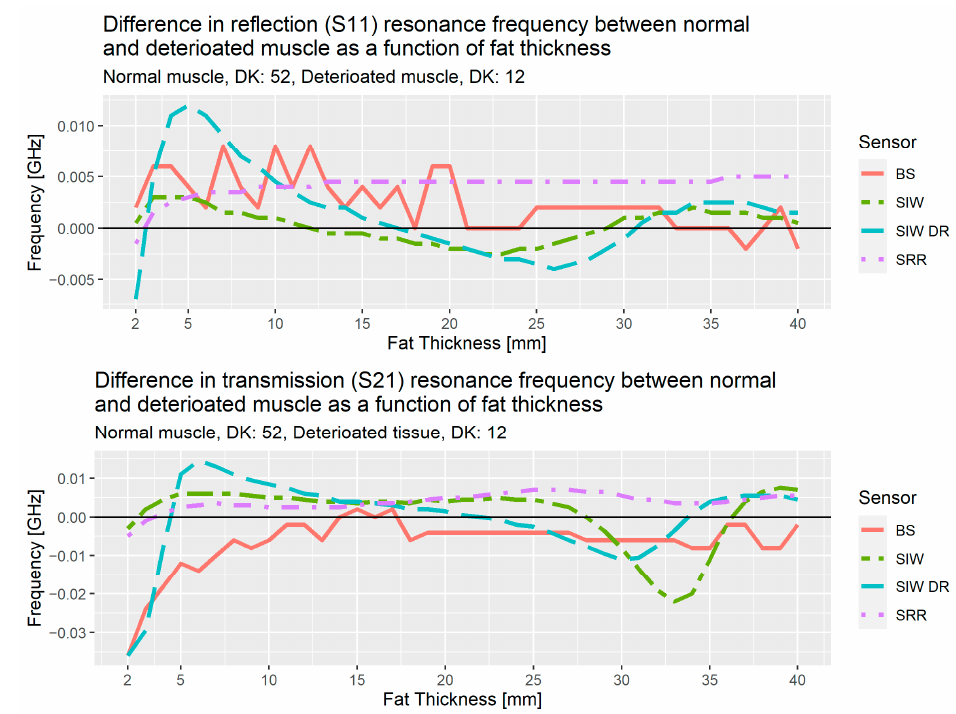
Figure 16. Difference in resonance frequency for reflection and transmission as a function of fat thickness.